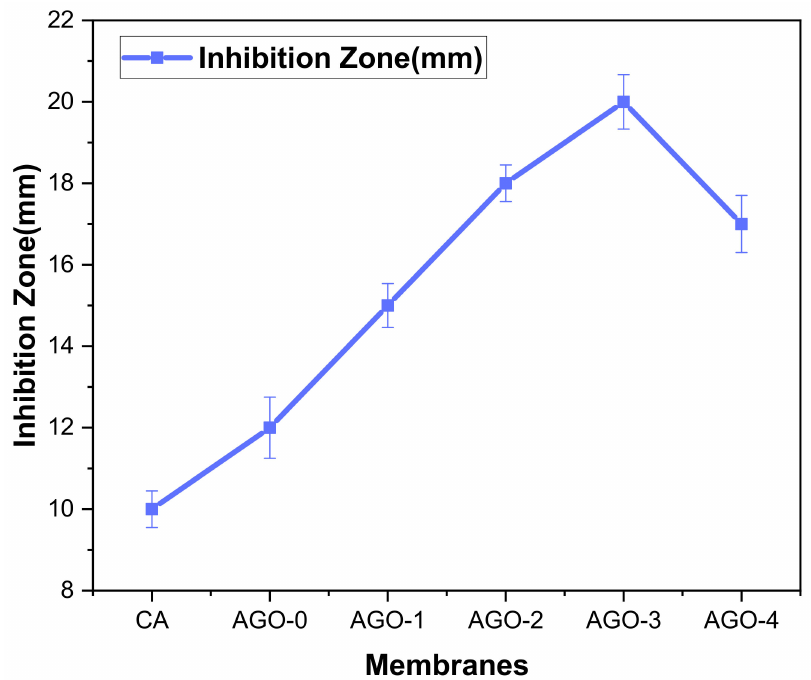
Figure 9. Antibacterial activity of AGO membranes.